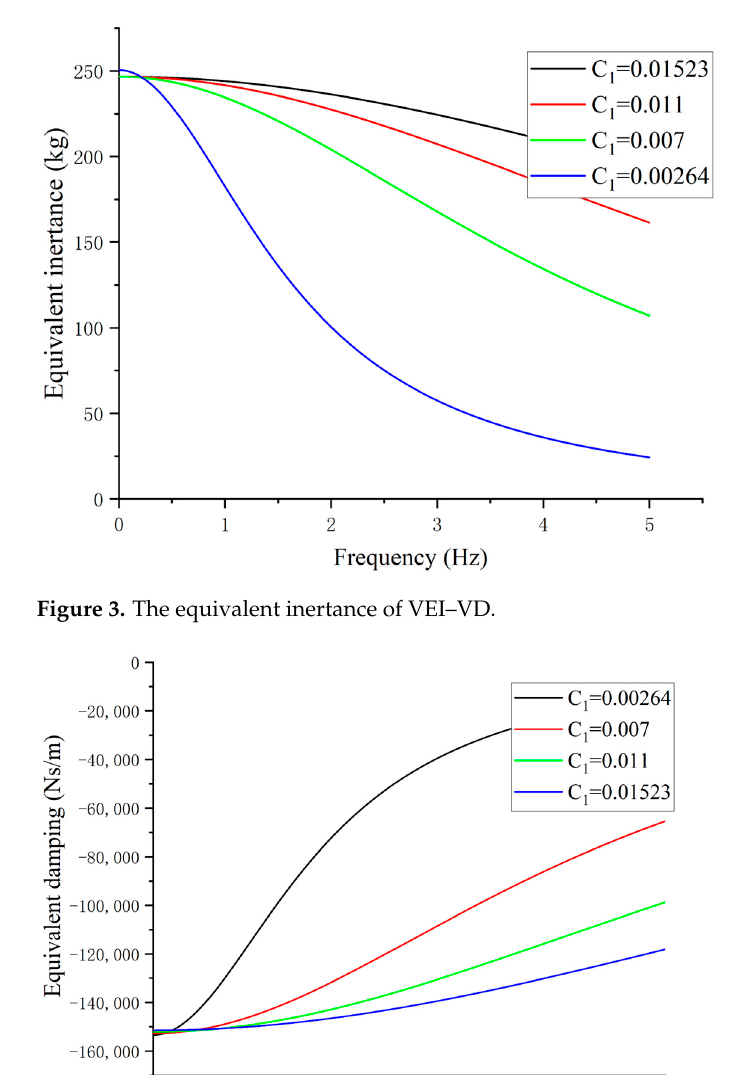
Figure 4. The equivalent damping of VEI–VD.